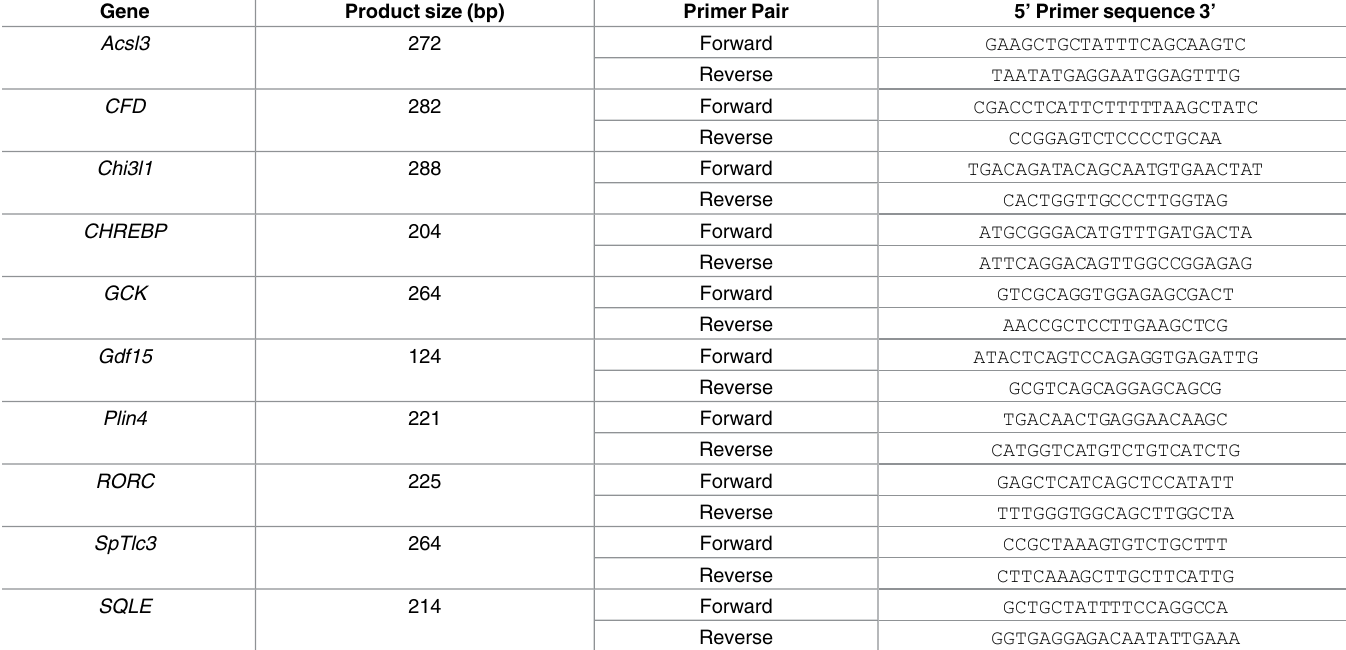
Table 2. Sequences of RT-PCR primers.